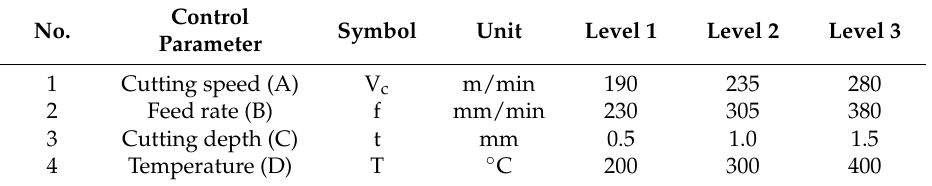
Table 5. Control parameters and their levels.